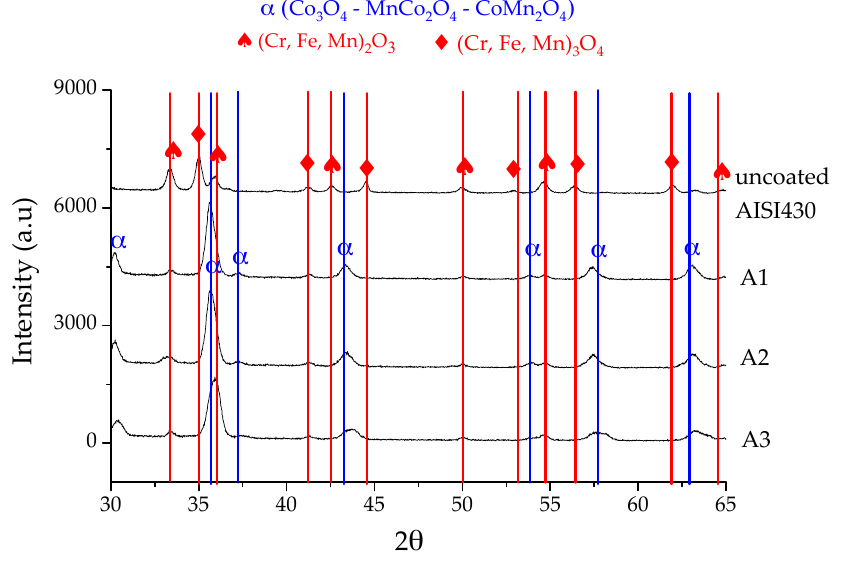
Figure 5. X-ray di ff ractograms for coated A1, A2 and A3 samples and uncoated AISI 430 sample after Figure 5. X-ray diffractograms for coated A1, A2 and A3 samples and uncoated AISI 430 sample after thermal oxidation process at 800 ◦ C for 300 thermal oxidation process at 800 °C for 300 h.